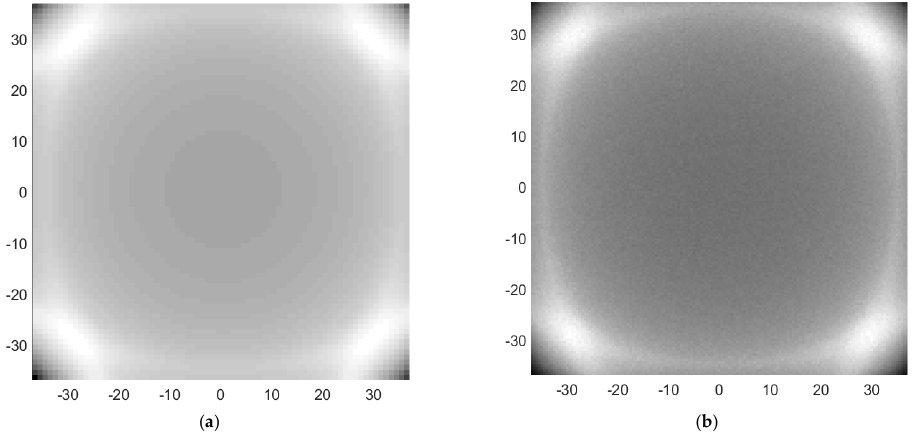
Figure 8. Normalized irradiance pattern of reflective system, detector at z = 250 mm: ( a ) flowline computation; ( b ) raytrace computation.